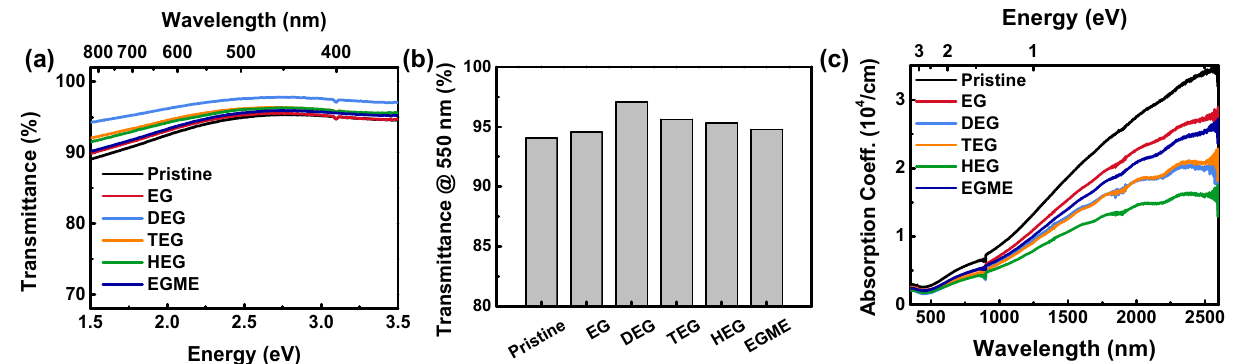
Figure 2. ( a ) Transmittance spectra, ( b ) representative transmittance values at 550 nm, and ( c ) absorption coefficients of the PEDOT:PSS films processed with various solvent additives at the concentrations of 1 M.